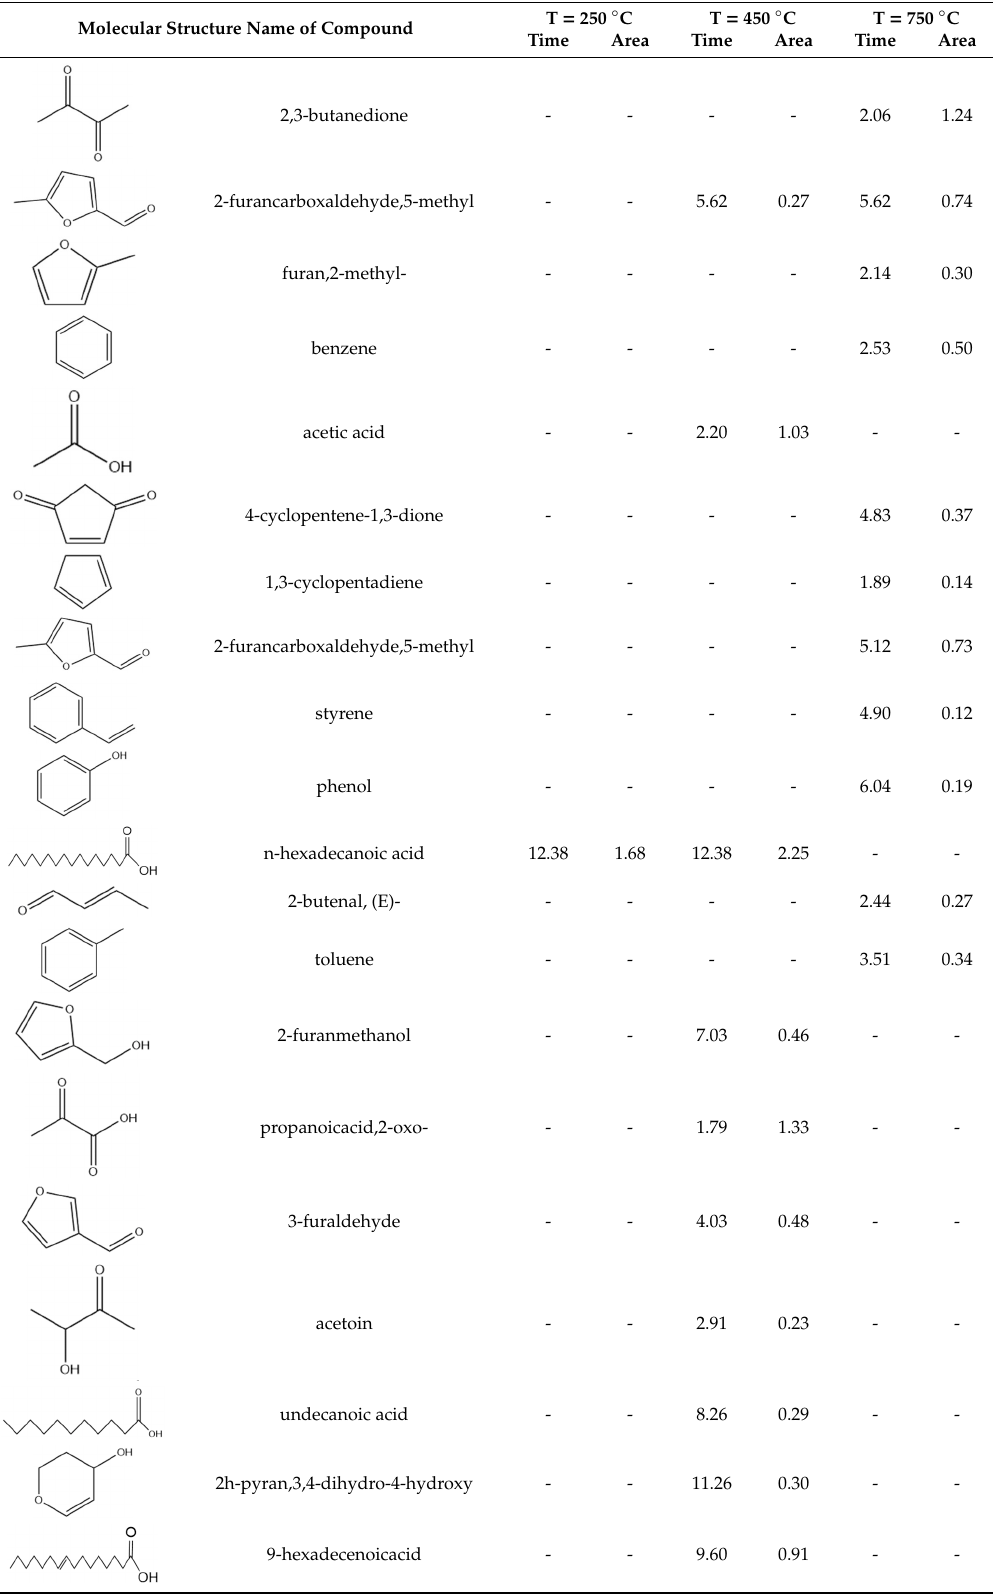
Table 2. Pyrolysis products of ZnAlg/Cu 2 O at different temperatures.